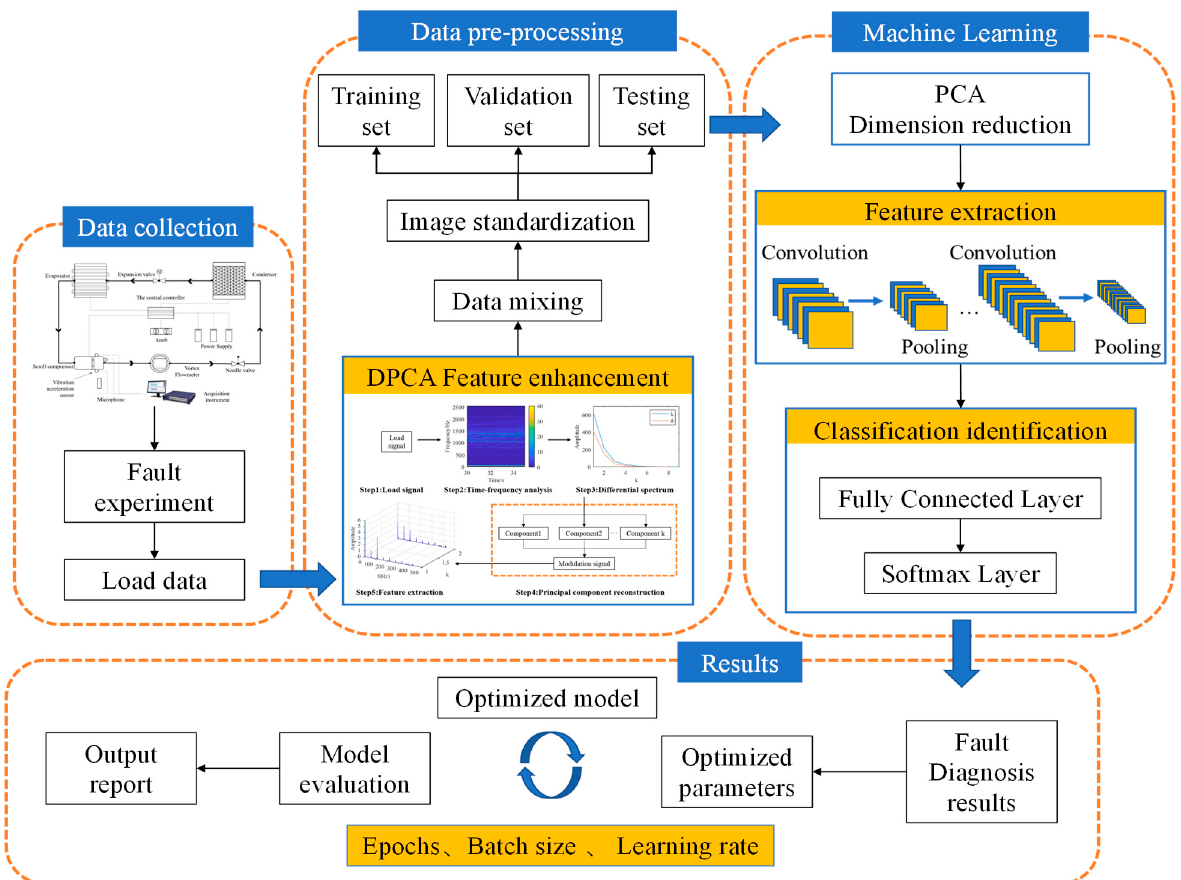
Figure 1. Fault diagnosis strategy schematic diagram.